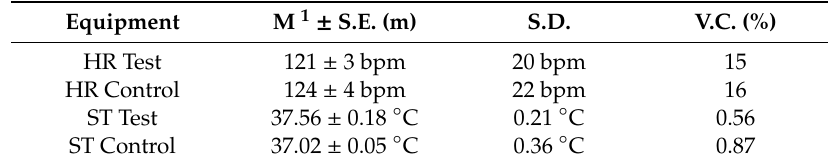
Table 4. Mean and variability of HR and ST data during the measurement